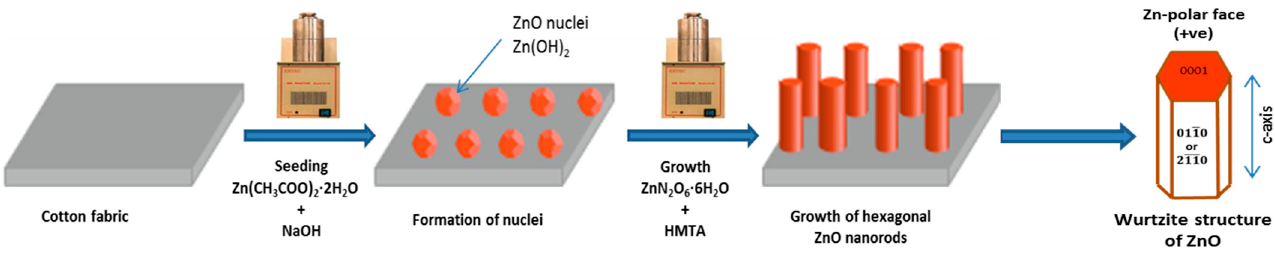
Figure 1. Schematic formation of ZnO-nanorod-coated cotton fabric.